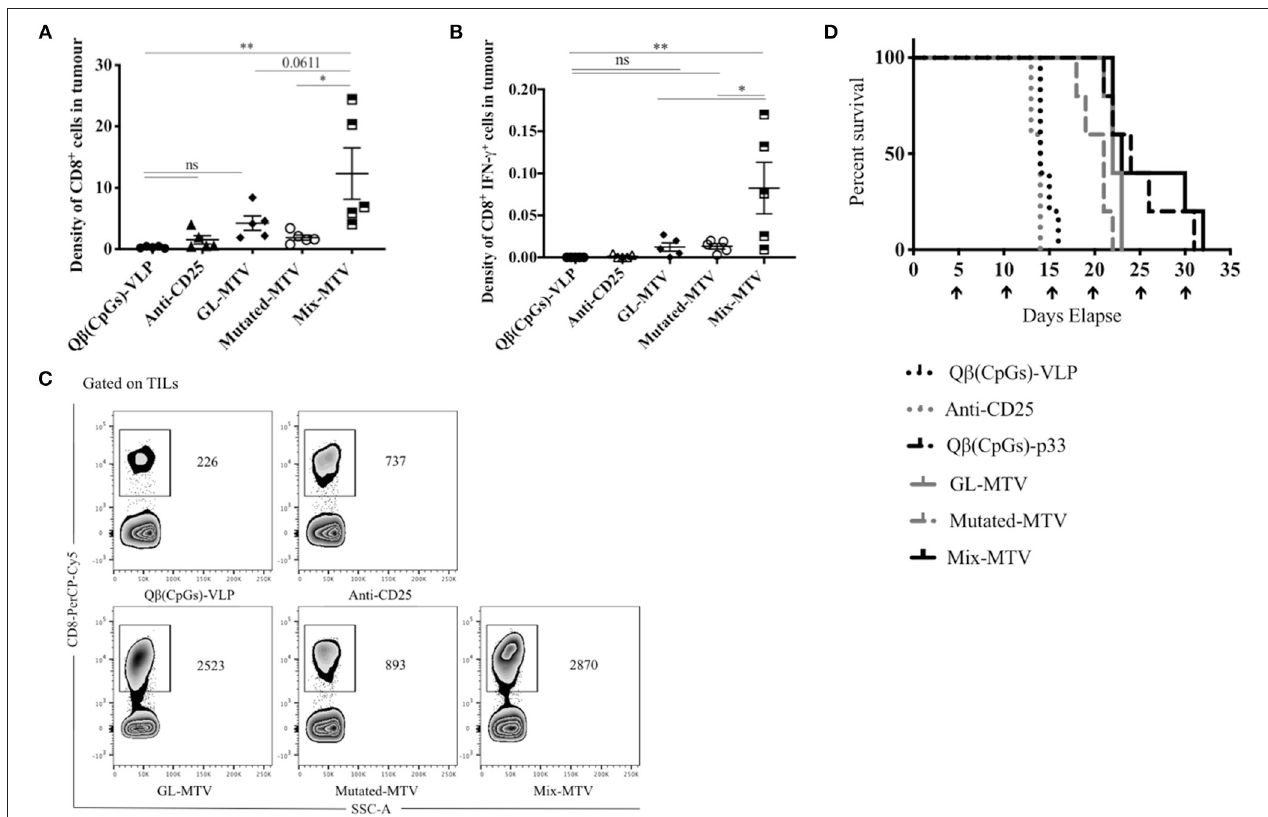
FIGURE 6 | Mix multi-target VLP-based vaccine increased CD8 + T-cell infiltration into B16F10 tumor and enhanced the survival. (A) Density of CD8 + T-cells (means ± SEM) in tumor , pre-gated on TILs in the groups vaccinated with Q β (CpGs)-VLPs, anti-CD25, GL-MTV, Mutated-MTV, and Mix-MTV. The density measured by dividing the total number of CD8 + T-cells in each tumor by its volume. (B) Density of CD8 + IFN- γ + secreting cells (means ± SEM) in tumor, pre-gated on TILs in the vaccinated groups. Statistical analysis by one-way ANOVA. (C) Representative FACS plots showing the total number of CD8 + T-cells in each tumor in the vaccinated groups. (D) Survival of mice in the vaccinated groups, mice were euthanized when the tumor reached 1,000 mm 3 . The arrows indicate vaccination time. Statistical analysis by log-rank test. The groups of GL-MTV, Mutated-MTV, and Mix-MTL were combined with anti-CD25mAb in all experiments. ( n = 5 ) mice per group, one representative of 3 similar experiments is shown. * P < 0.05 ; ** P < 0.01 ; *** P < 0.001 ; **** P <